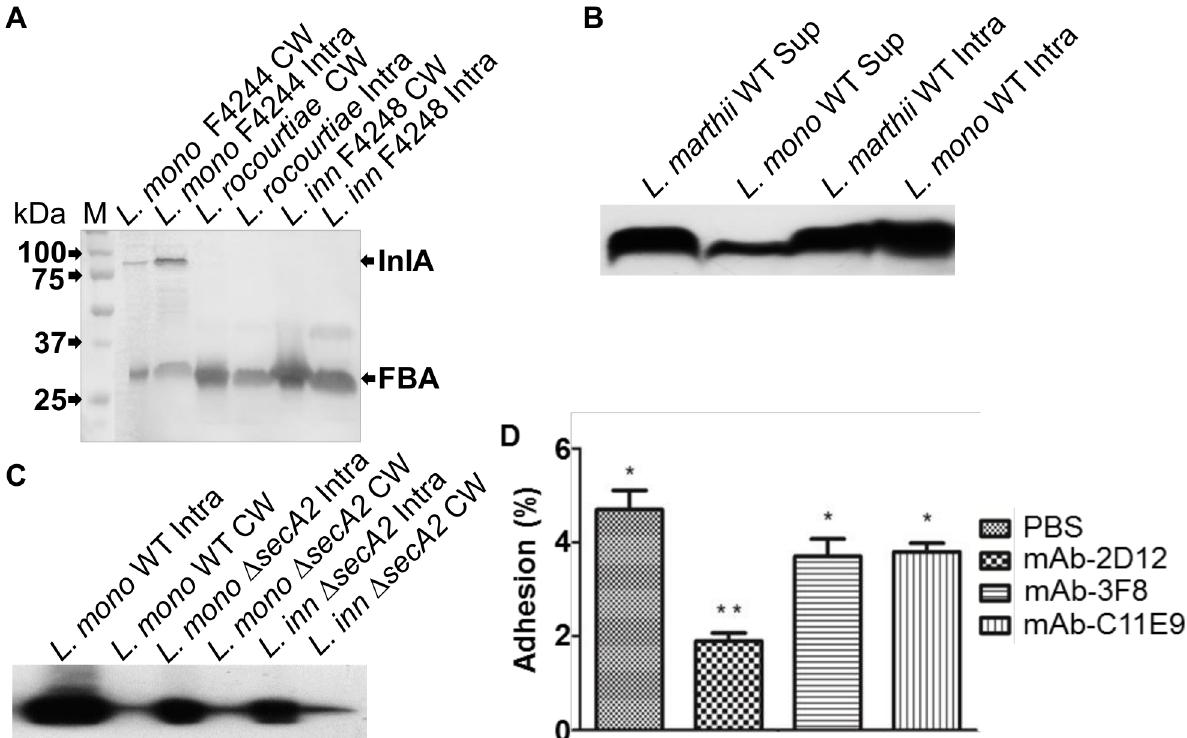
Fig 3. Cell localization and adhesion experiments for FBA characterization. (A) Western blot using mAb-3F8 show that FBA protein is present in the cell wall and intracellular (membrane and cytoplasm) of three different Listeria species tested. The top band shows reaction with anti-InlA mAb-2D12. (B) When using only mAb-3F8 in Western blot, it is possible to observe that FBA is also present in the culture supernatant of two different Listeria species. (C) Due to the presence of FBA in the cell wall, a L . monocytogenes mutant ( Δ secA2 ) was used to inquire the secretion pathway of FBA. However, no difference in band intensity was observed in the cell wall (CW) or intracellular (Intra) fractions between the wild type (WT) and mutant strains, indicating that the secretory pathway of FBA is not SecA2-dependent. (D) Adhesion experiments in vitro using HCT-8 cells show that mAb-3F8 has no inhibition activity, since it ’ s pre- incubation with L . monocytogenes cells shows similar levels of adhered bacteria as the negative controls with PBS and mAb-C11E9. The positive control mAb-2D12 (anti-InlA) was the only one to show significant reduction in